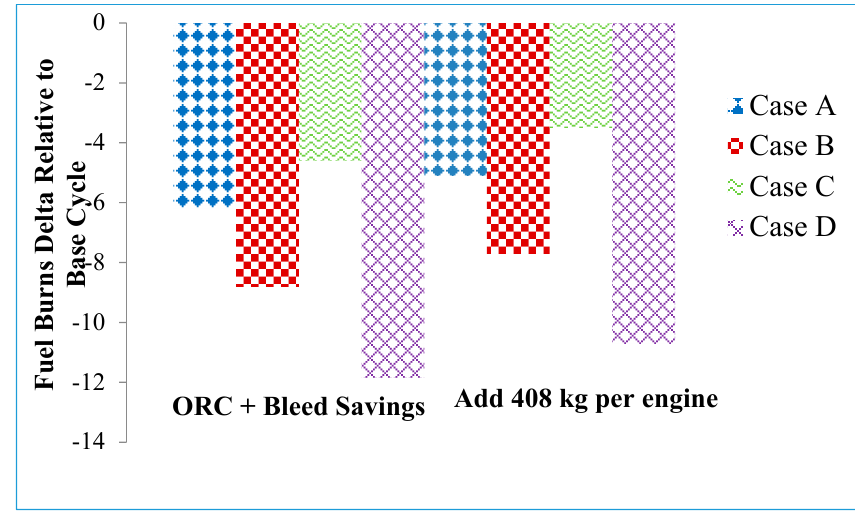
Figure 13. The values of fuel burn relative to the base cycle.